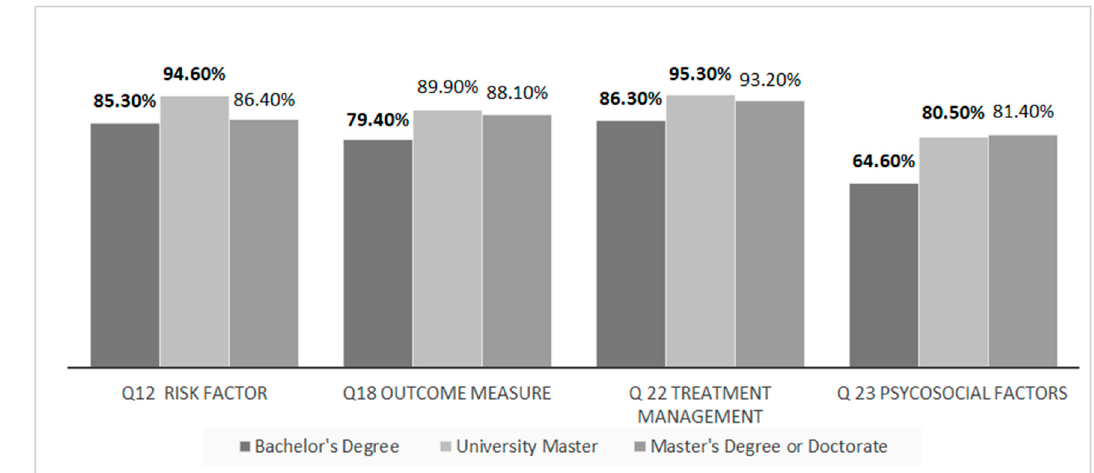
Figure 3. Inferences between educational qualifications and correct answers (Q12, Q18, Q22, Q23). Acronyms: Q: question. Bold values outside the box are the ones with statistical significance in the residual p -values. Tabled as percentage of respondent ( n = 508).